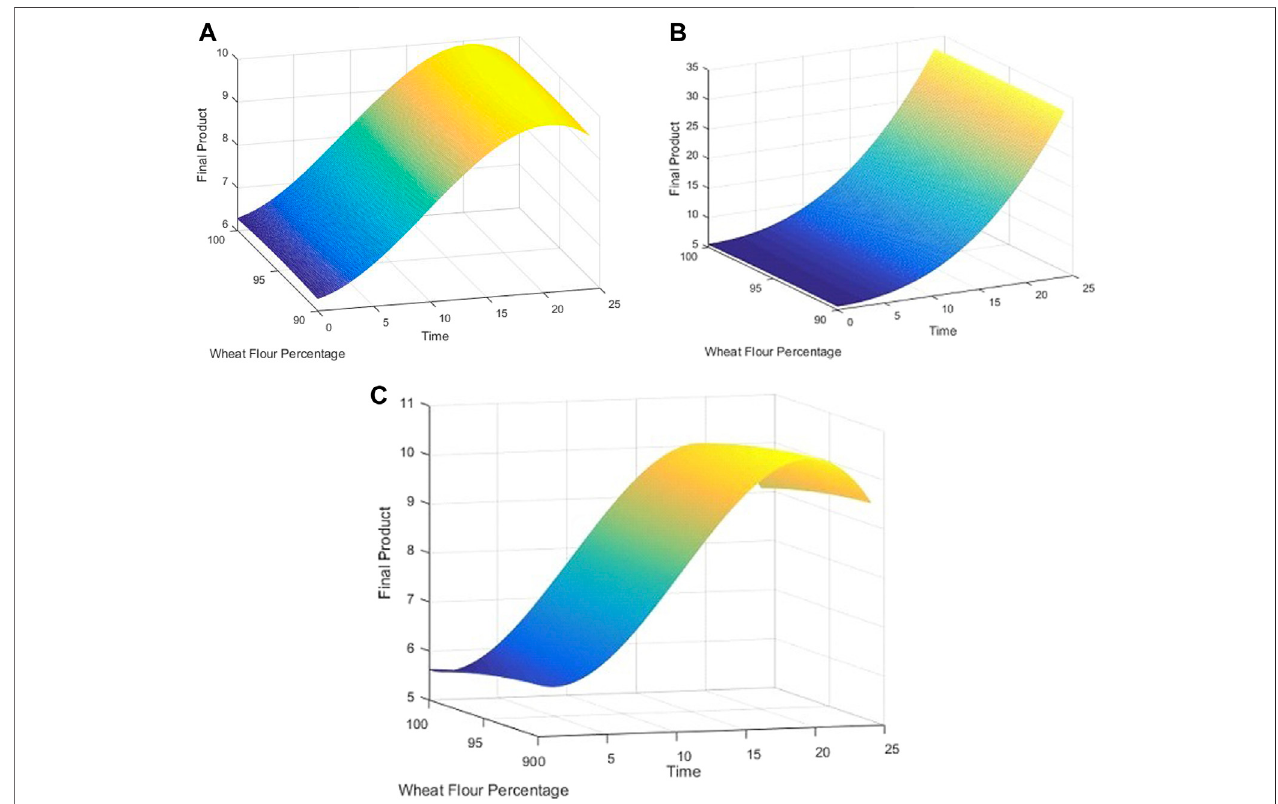
FIGURE 5 | 3D plots for (A) L. plantarum ; (B) L. casei ; (C) co-cultures of L. plantarum and L. casei